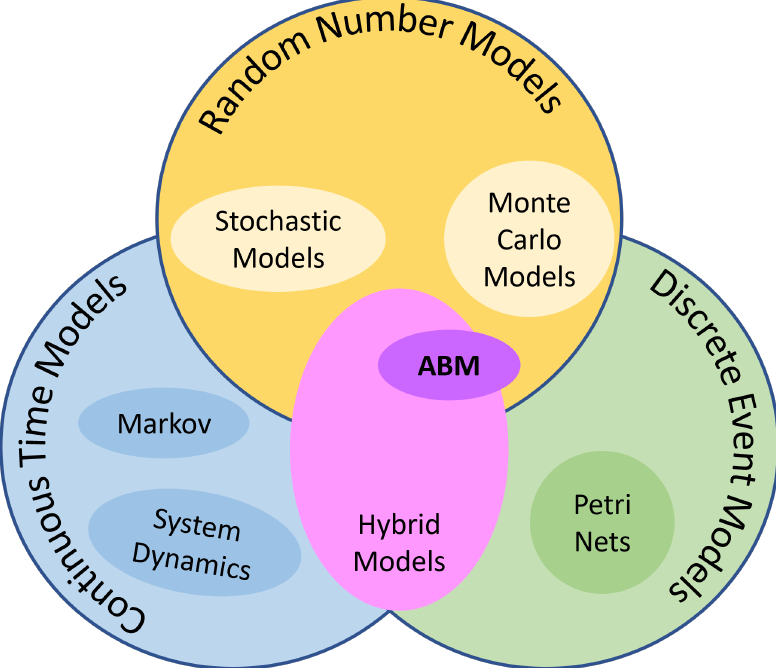
Figure 1. Classification of dynamic modeling